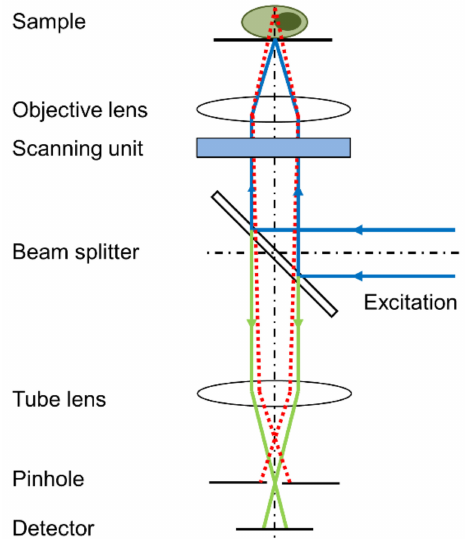
Figure 4. Principle of a confocal laser scanning microscope (CLSM); only a confocal beam passes the pinhole, while non-confocal beams are blocked (reproduced from Ref. [27] with modifications). Lateral resolution results from the diffraction-limited laser spot, as defined by the Rayleigh criterion. If the pinhole diameter is larger than the diameter of the so-called